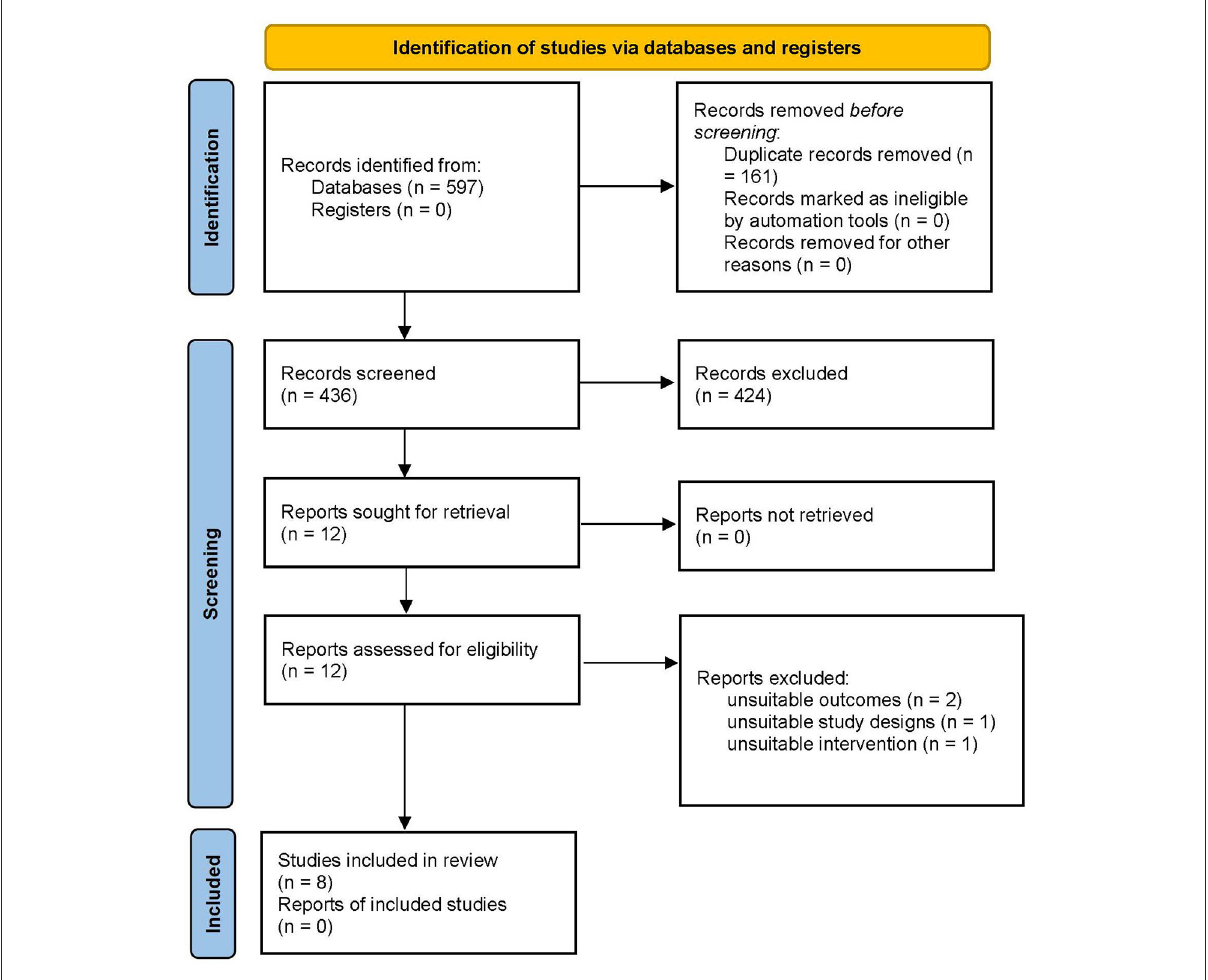
FIGURE1 PRISMA flow